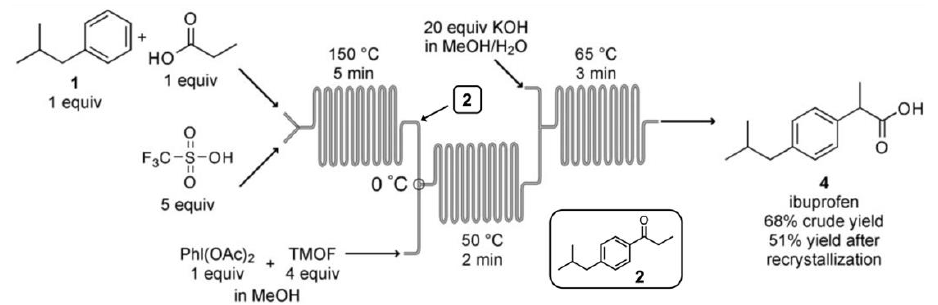
Figure 21. Continuous flow synthesis of ibuprofen. Reproduced with permission of [173]. Copyright 2009 Wiley-VCH.